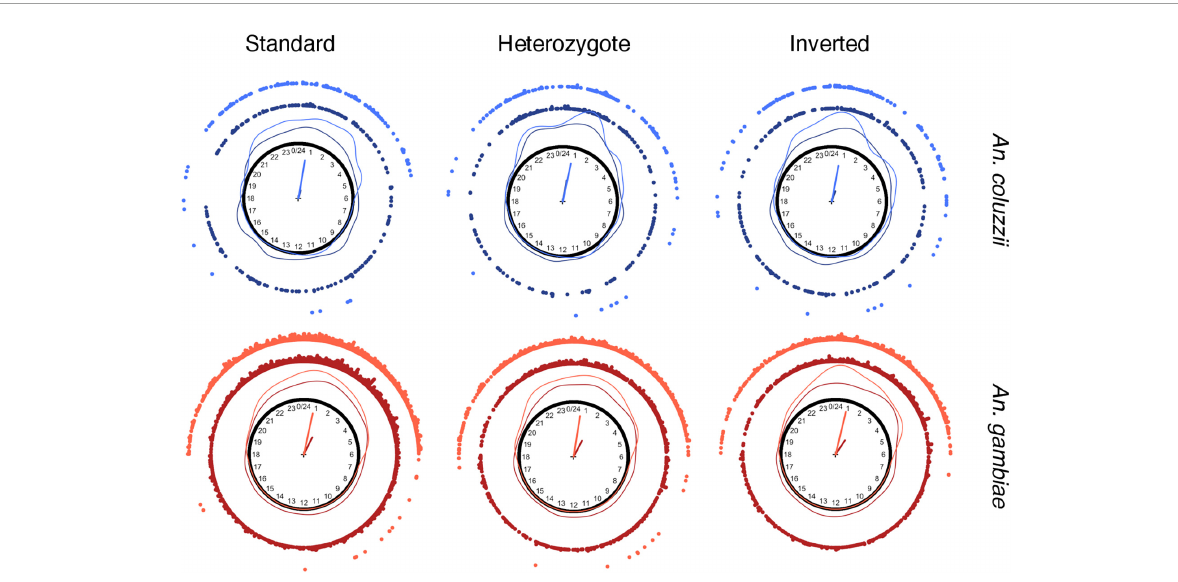
FIGURE3 Circular representation of biting events for each karyotype and species. Biting events are represented by points, the kernel distributions by lines, and the mean directions ( θ ) and resulting lengths ( R) are depicted as arrow vectors on the unit circle. Darker colors represent indoor collections, and lighter colors outdoor